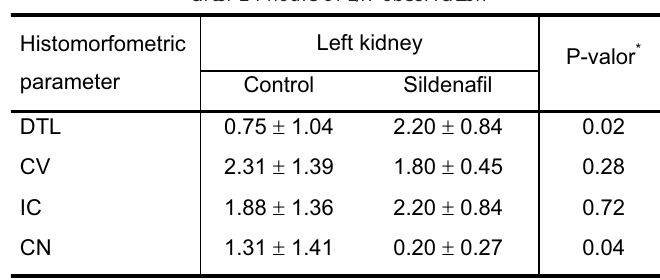
TABLE 3 - Data set and its statistical test scores for the